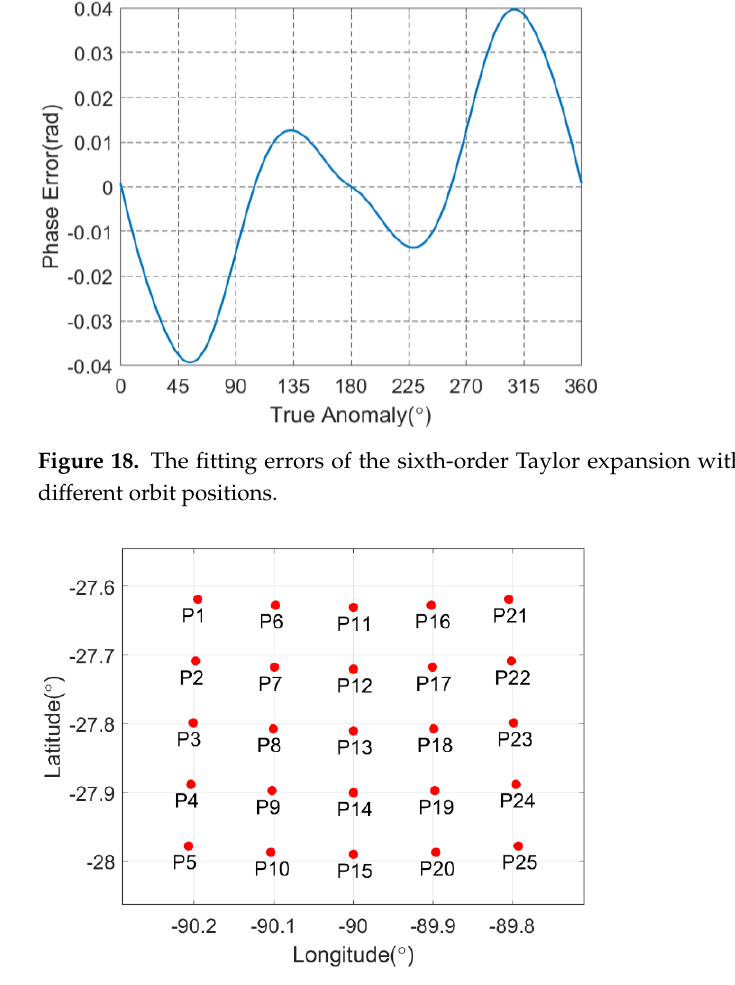
Figure 19. The distribution of twenty-five point targets at perigee.